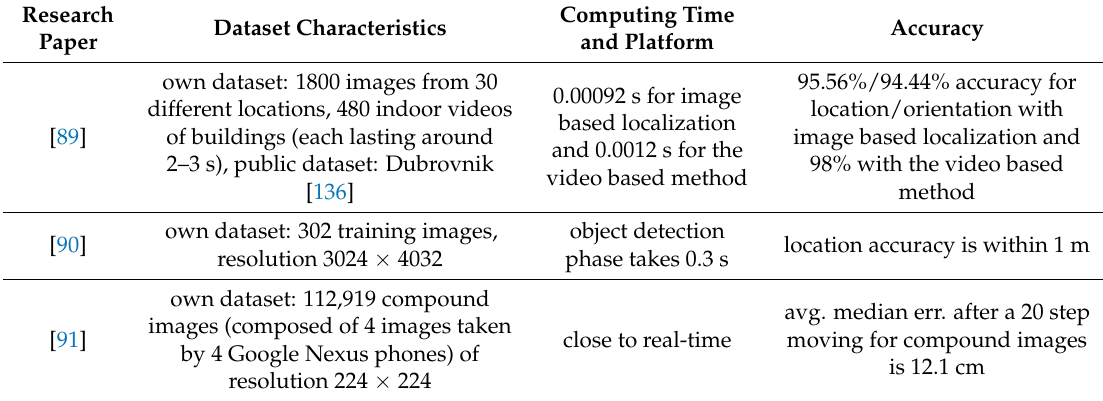
Table 9. Characteristics of indoor localization solutions with real image/feature databases, 2D mobile cameras, and artificial